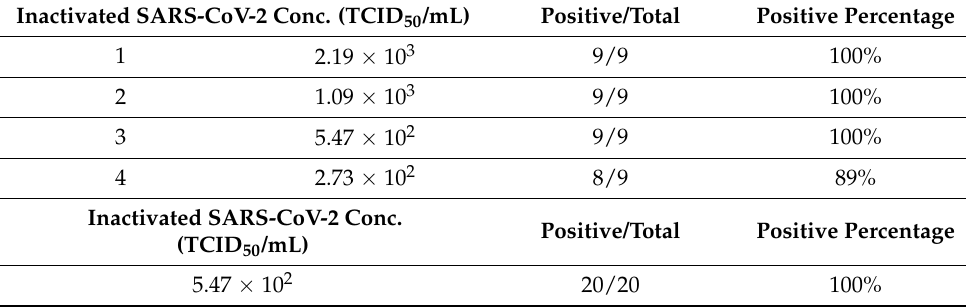
Table 2. LOD for NP-mAb-40/7 LFIA strips using inactivated SARS-CoV-2 (USA-WA1/2020) in the human nasal